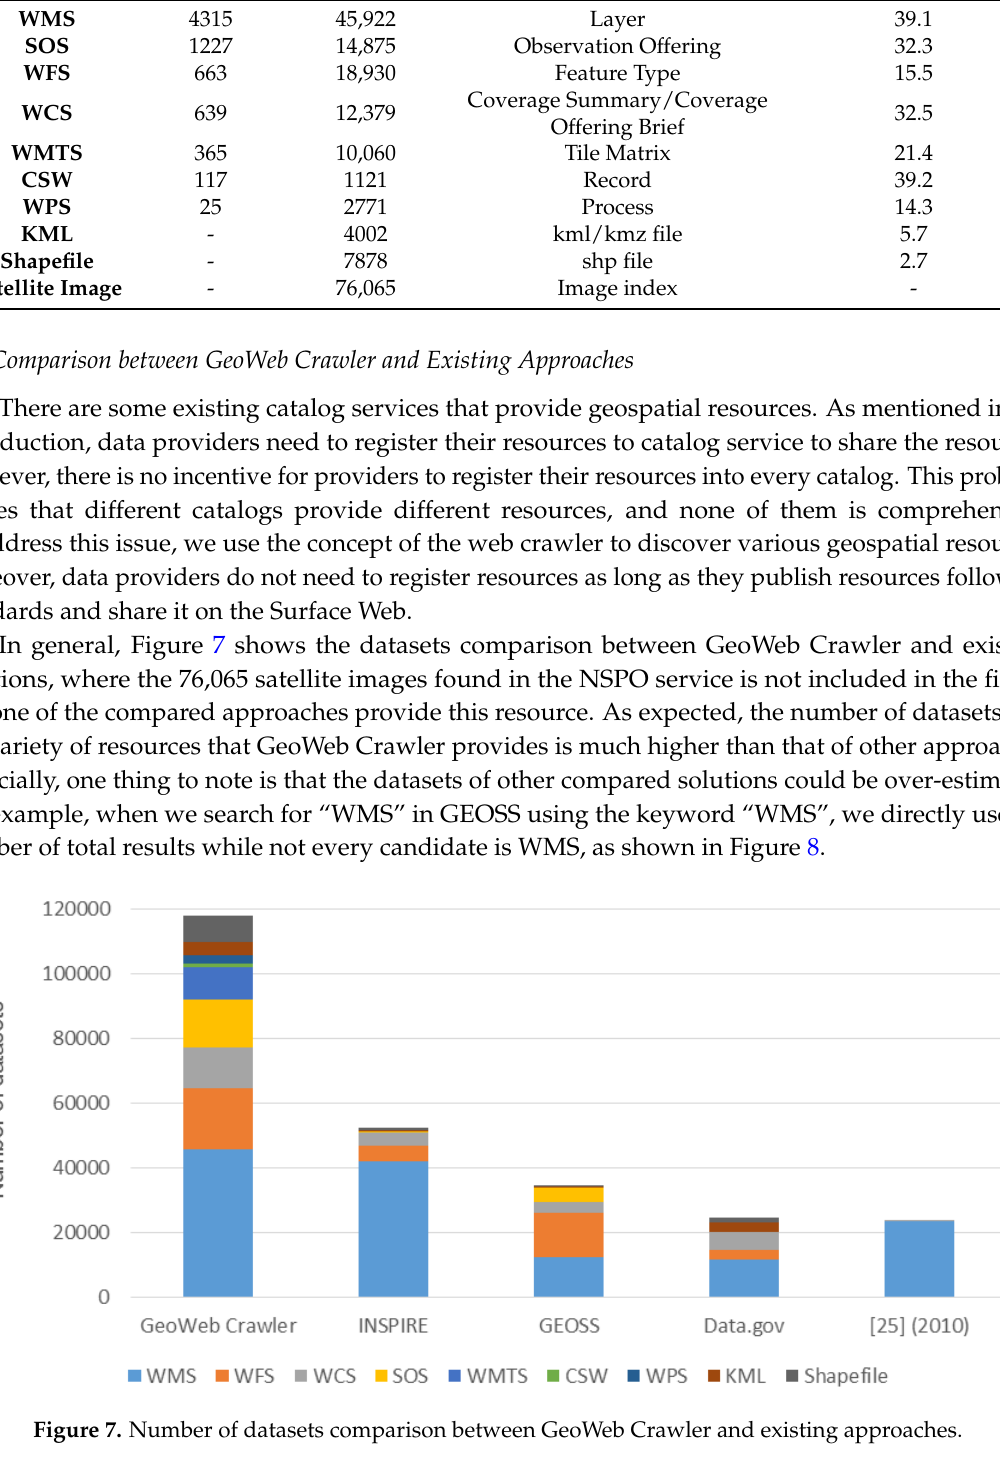
Table 3. GeoWeb crawling result.